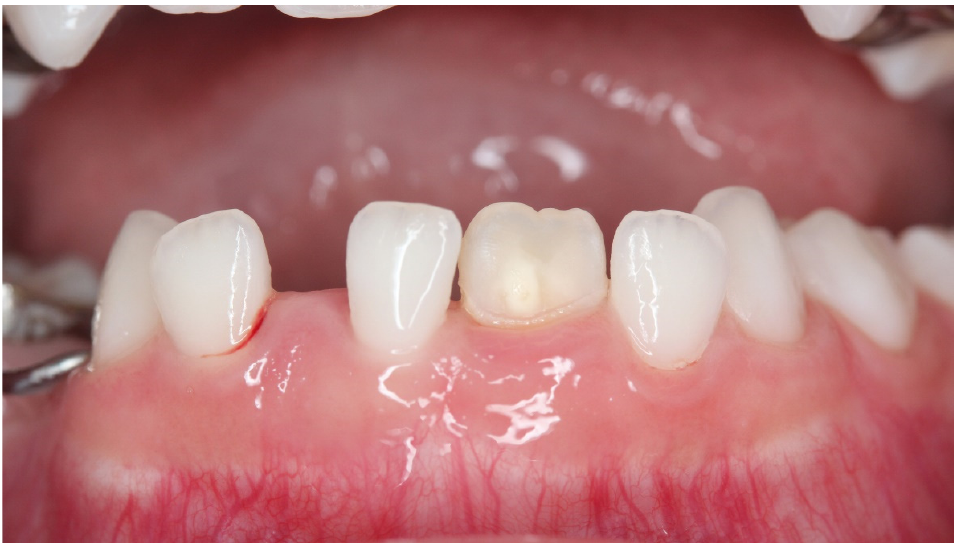
Figure 10. Case 4: Intraoral photograph before treatment.